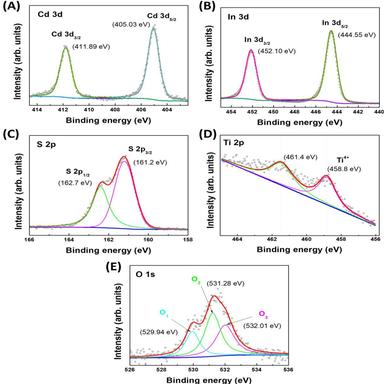
High-resolution XPS spectra of (A) Cd 3d, (B) In 3d, (C) S 2p, (D) O 1 s, and (E) Ti 2p elements for (×4)-CdIS/TONR/FTO heterostructure photoanode.